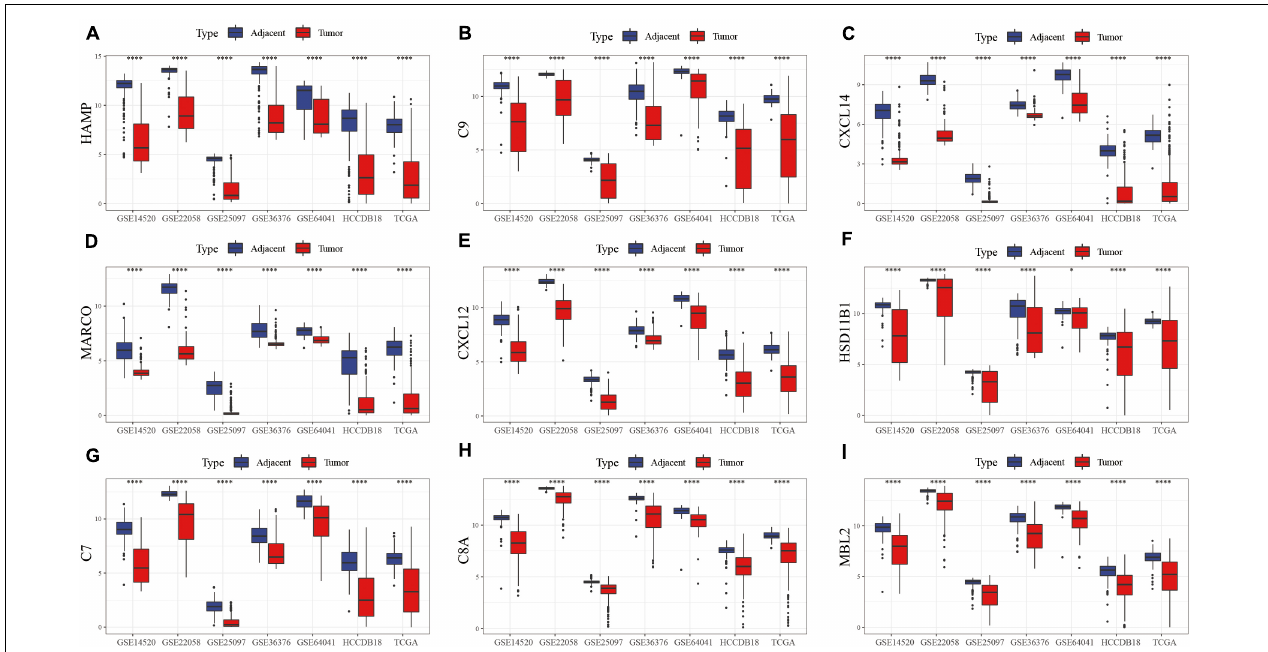
FIGURE 2 | Box map of DEGs expression in tumor and para-cancer samples in different data sets. The differences in the expression of (A) HAMP, (B) C9, (C) CXCL14, (D) MARCO, (E) CXCL12, (F) HSD11B1, (G) C7, (H) C8A, and (I) MBL2 genes, respectively, in tumor and adjacent samples.